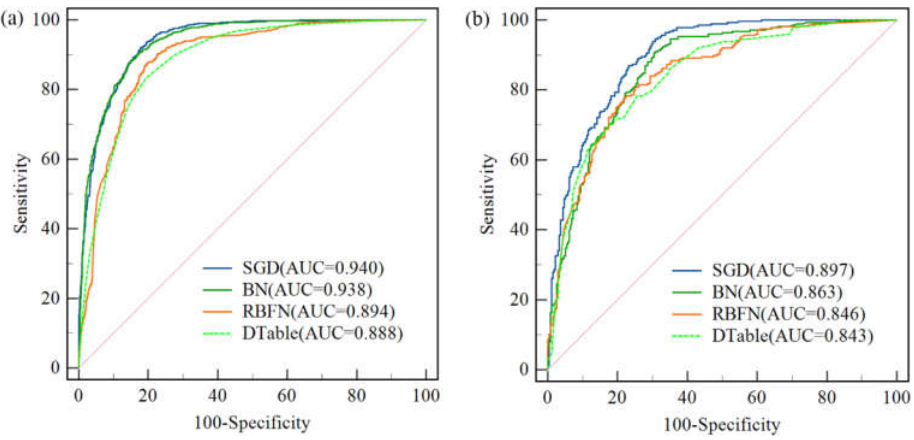
Figure 12. ROC curve and AUC for four models: ( a ) training dataset and ( b ) validation dataset.